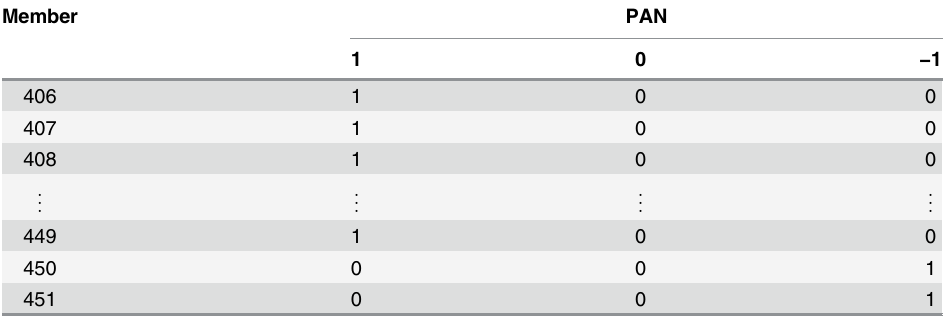
Table 16. A decomposition of Table 10 into multi-tables of Boolean-Valued for PPP. Member PPP 1 0 − 1 452 1 0 0 453 1 0 0 454 1 0 0 . .. . .. . .. . .. 483 1 0 0 484 0 1 0 485 0 1 0 486 0 1 0 . .. . .. . .. . .. 489 0 1 0